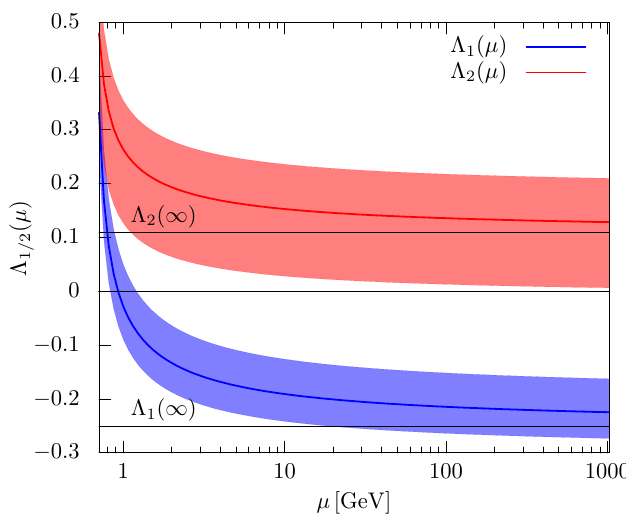
Figure 14. Scale dependence of the large- N c ChPT LECs Λ 1 and Λ 2